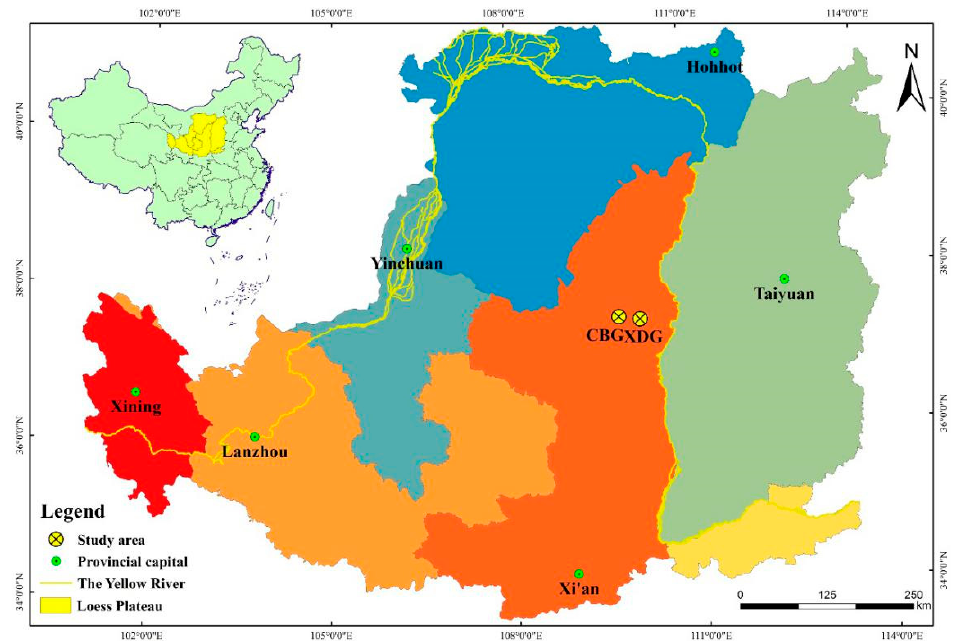
Figure 2. Location of the two experimental watersheds of Chabagou (CBG) and Xindiangou (XDG). The XDG watershed (latitude: 37°29 ′ N, longitude: 110°08 ′ E, elevation: 990–1010 MASL, area: 30